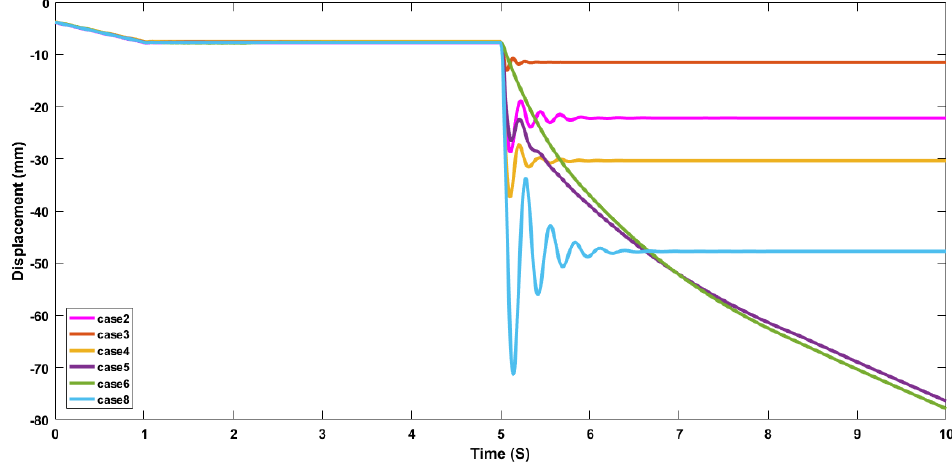
Table 2. Vertical displacement after removing a column in the stories.